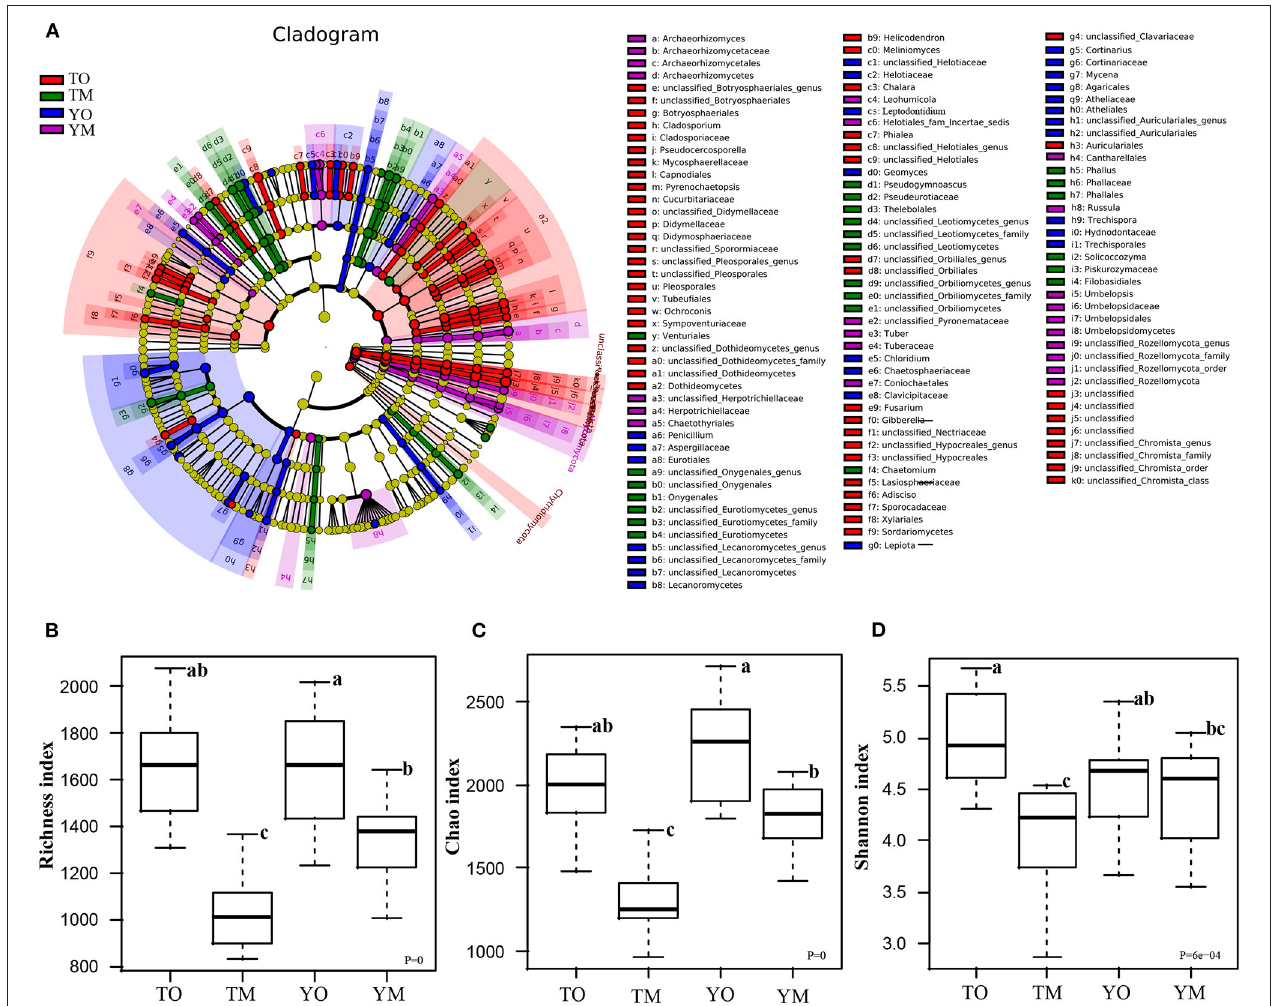
FIGURE 4 | Linear discriminant analysis effect size (LEfSe) among the four groups (A) . Effects of soil horizon on fungal richness index (B) , Chao1 index (C) , and Shannon index (D) . TO represents the O horizon at Tiantangzhai Nature Reserve. TM represents the M horizon at Tiantangzhai Nature Reserve. YO represents the O horizon at Yaoluoping Nature Reserve. YM represents the M horizon at Yaoluoping Nature Reserve. The lower case letters mean significant difference.